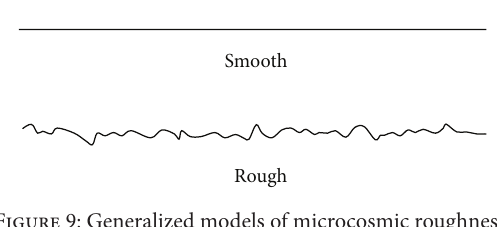
Figure 9: Generalized models of microcosmic